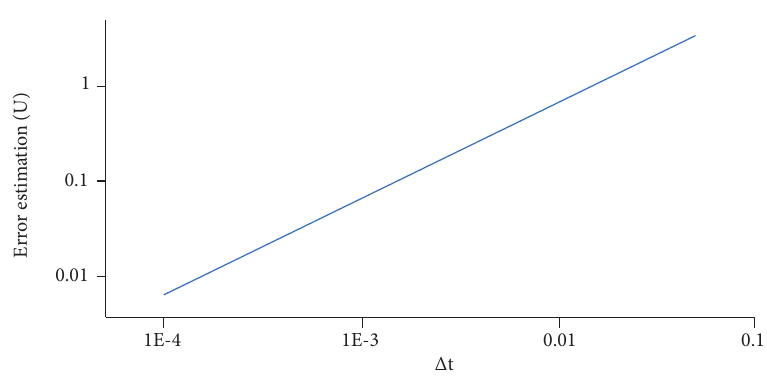
Figure 15 shows the error estimation ( U ) in relation to variation of time length. ∆t . The estimated error diminishes as the grid refinement in time variable increases.